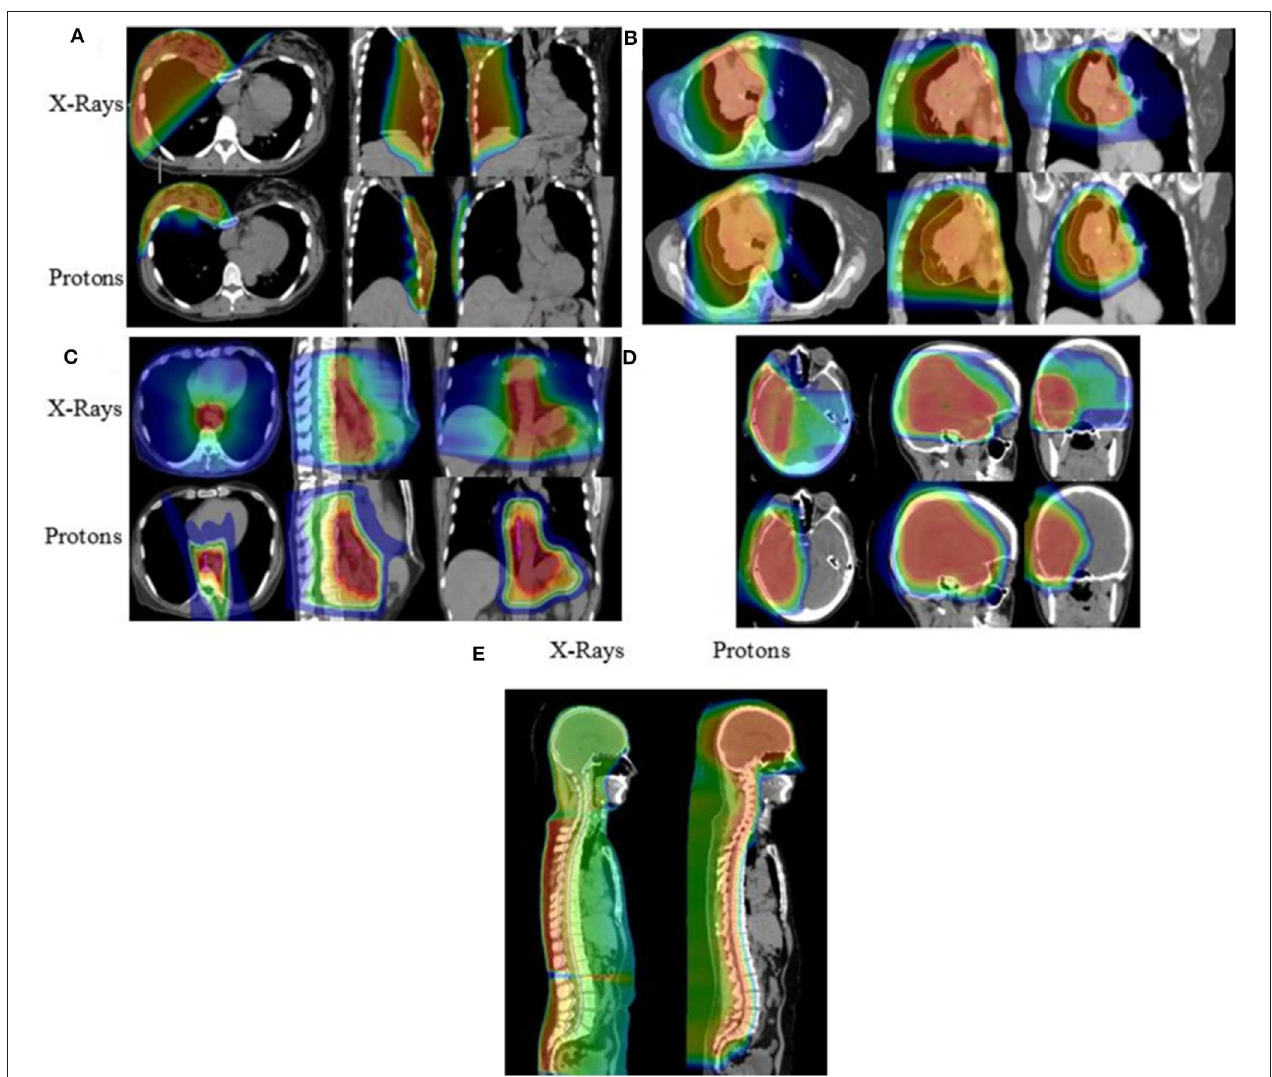
FIGURE 4 | Isodose distributions of the proton radiotherapy plans with comparison x-ray plans generated for patients treated with PBT including patients with (A) breast cancer, (B) locally advanced NSCLC, (C) esophageal cancer, (D) primary low-grade glioma, and (E) ependymoma receiving craniospinal